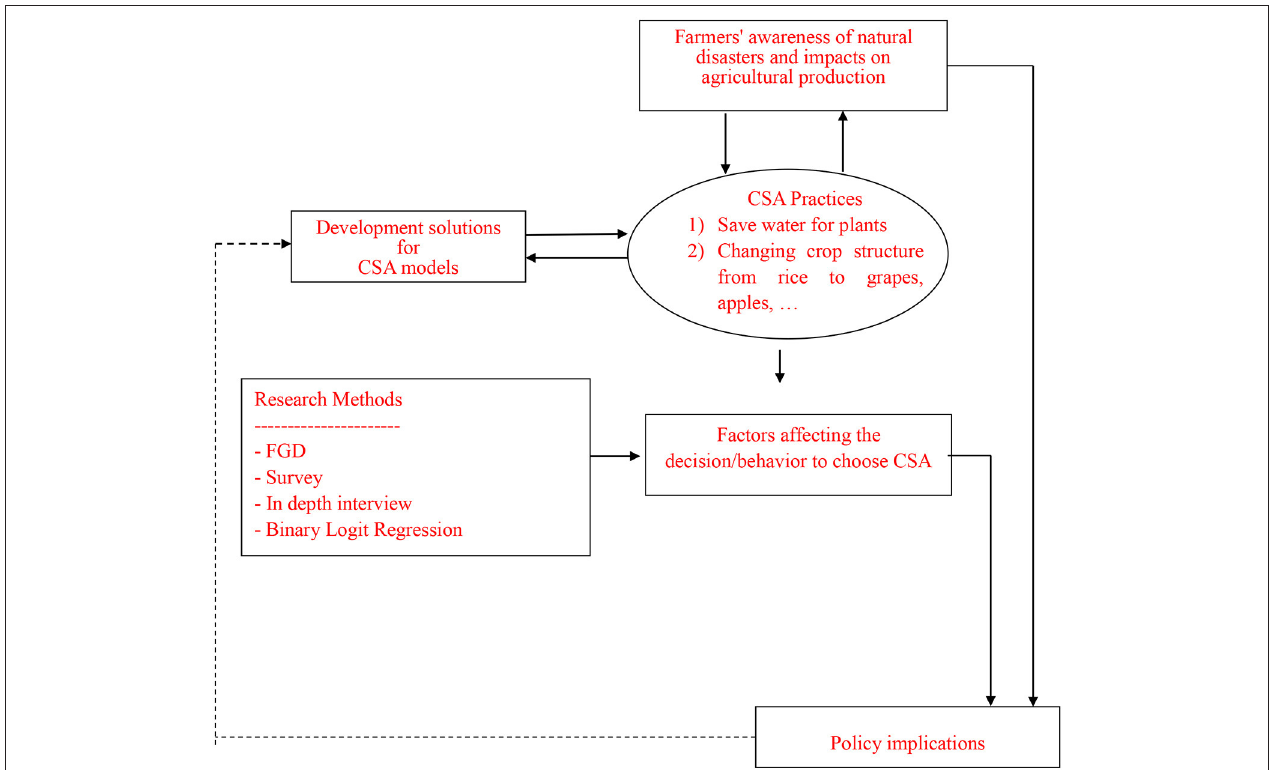
FIGURE 2 | Analytical framework of the study.